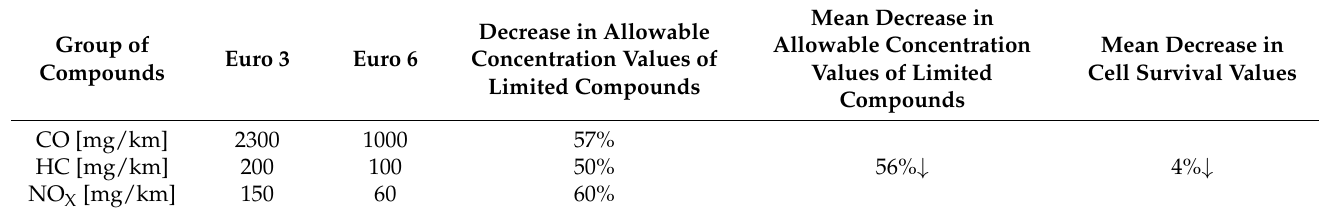
Table 4. List of the decreases in mean allowable concentration values of limited compounds and cell survival rates for tested Euro 6 vehicles compared to Euro 3